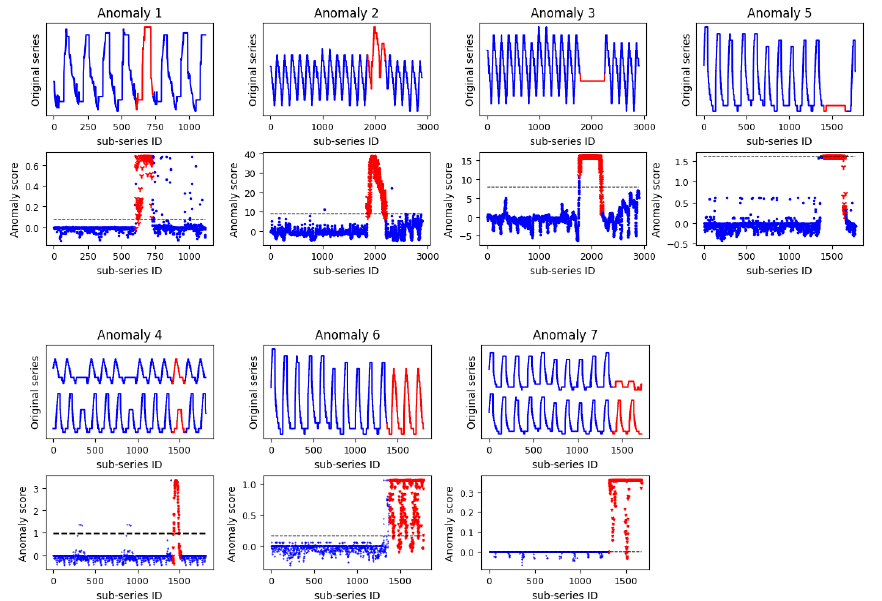
Figure 7. Anomaly scores for the seven subseries containing anomalies (for the original series, the blue solid lines denote the real normal series and the red lines denote the abnormal series; for the anomaly score, the blue solid dot denotes the real normal samples, the red * denotes the anomalies, the black dashed line denotes the anomaly detection threshold, and the subseries ID is the index of each point in the series).